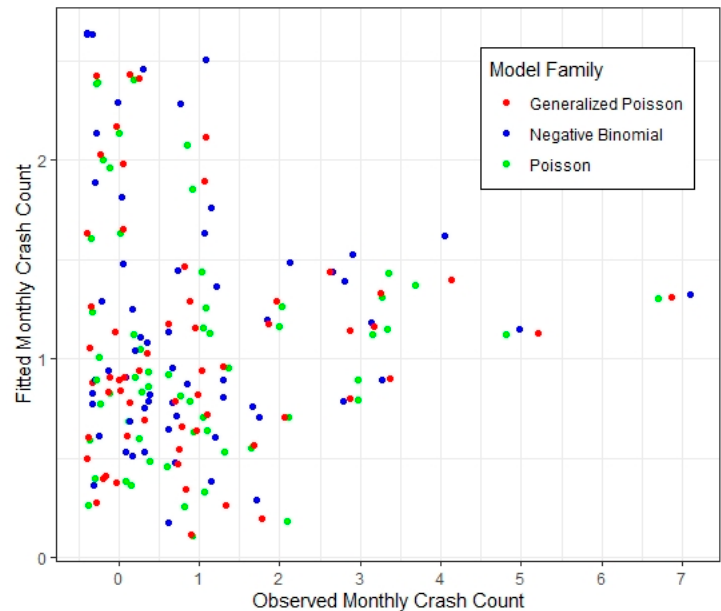
Figure 3. Segment fitted crash counts versus observed crash counts.